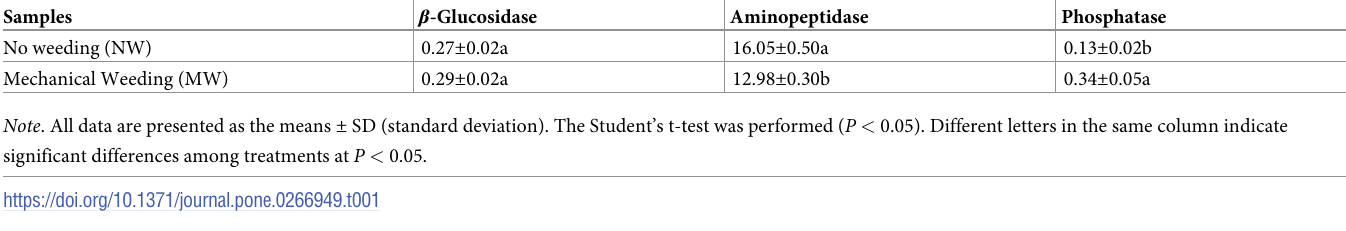
Table 2. Soil microbial biomass between the NW and MW treatments in star anise plantations (mg kg -1 ). Samples No weeding (NW) Mechanical Weeding (MW) Note . All data are presented as the means ± SD (standard deviation). The Student’s t-test was performed ( P < 0.05). Different letters in the same column indicate significant differences among treatments at P <